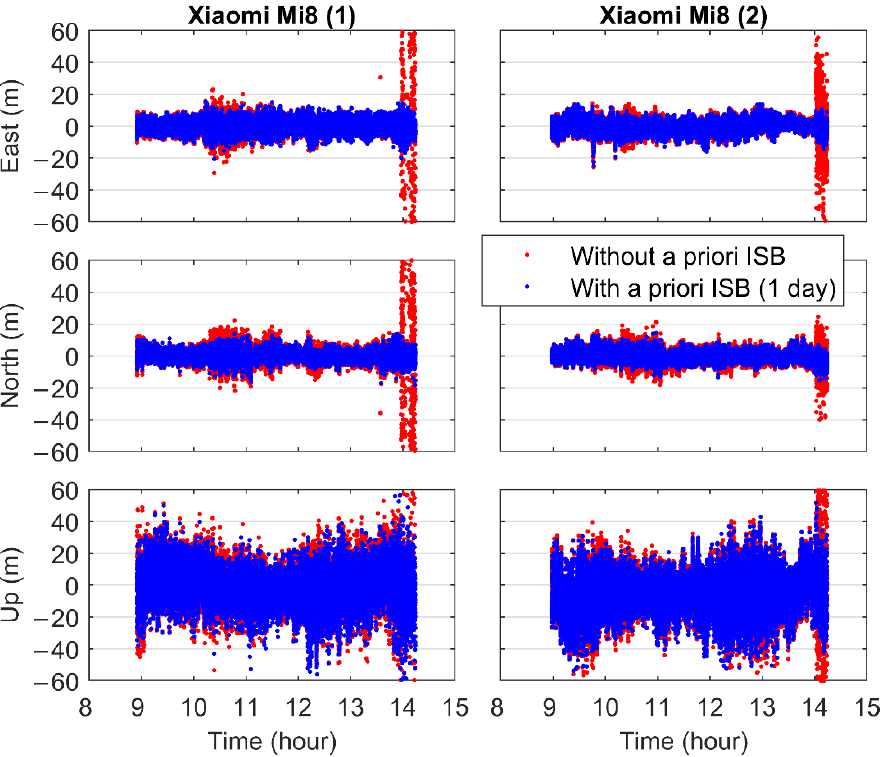
Figure 17. Epochwise positioning errors of four-system integrated SPP for two smartphones with and without a priori ISB constraints under a cutoff elevation of 40° on DOY 320 of 2020.